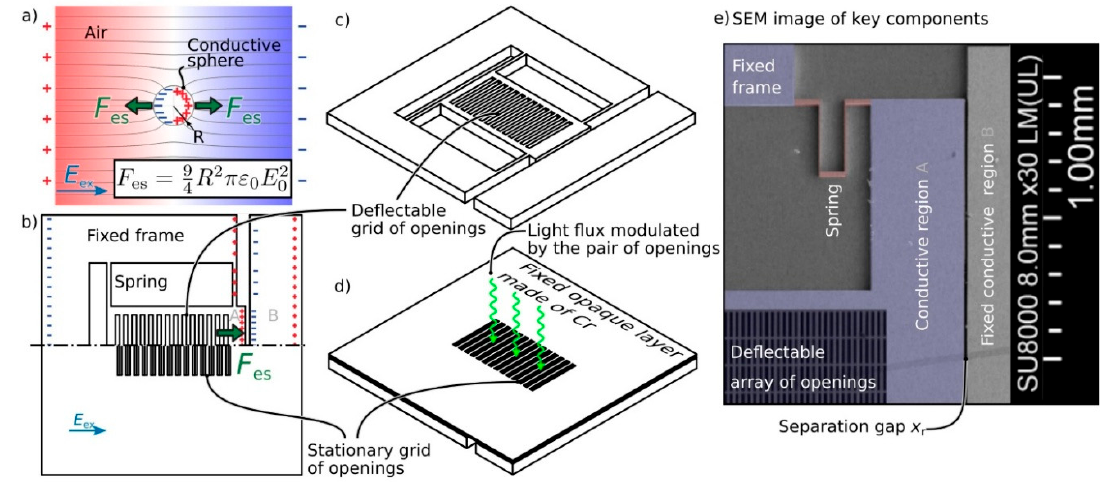
Figure 1. ( a ) Forces and field lines of a conducting sphere with radius R in an external field E ex . The electric field polarizes the sphere. Oppositely charged regions of the surface of the sphere experience an electrostatic force F es while maintaining polarization, ( b ) Polarization of different conductive domains of a schematic MEMS sensor and the resulting net force. ( c , d ) 3D-schematics of the key components, incorporating the openings for the optical readout, ( e ) Scanning electron microscope (SEM) image of a chip taken during fabrication depicting the key elements in the device layer.